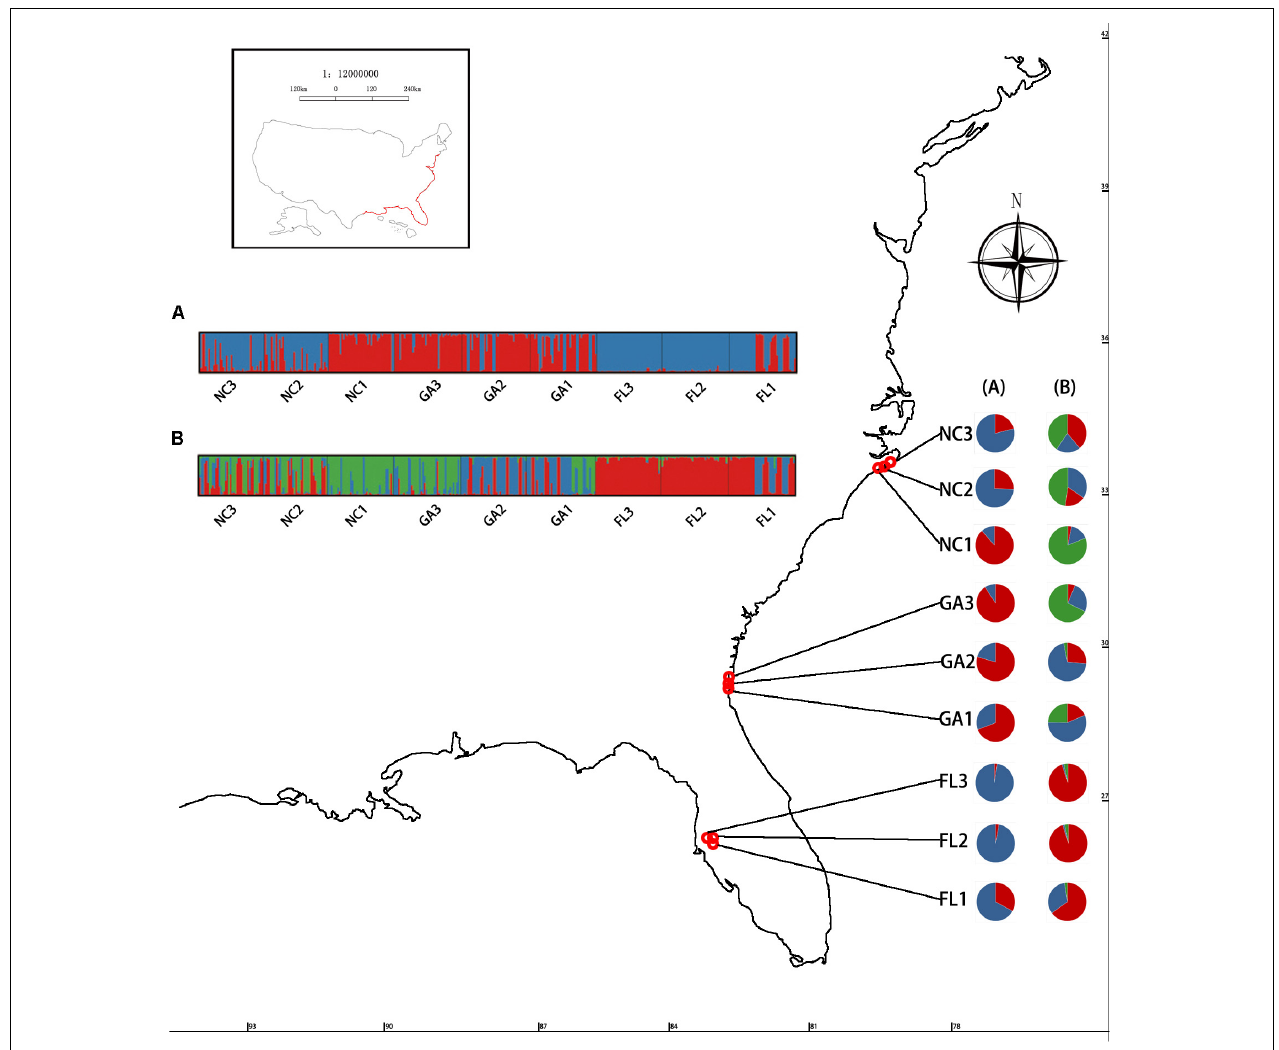
FIGURE 5 | Geographic distribution of the genetic groups on the coast of America detected using STRUCTURE analysis of Spartina alterniflora based on SSR data. K -values of the panel (cid:49) K = 2 (A) and (cid:49) K = 3 (B)